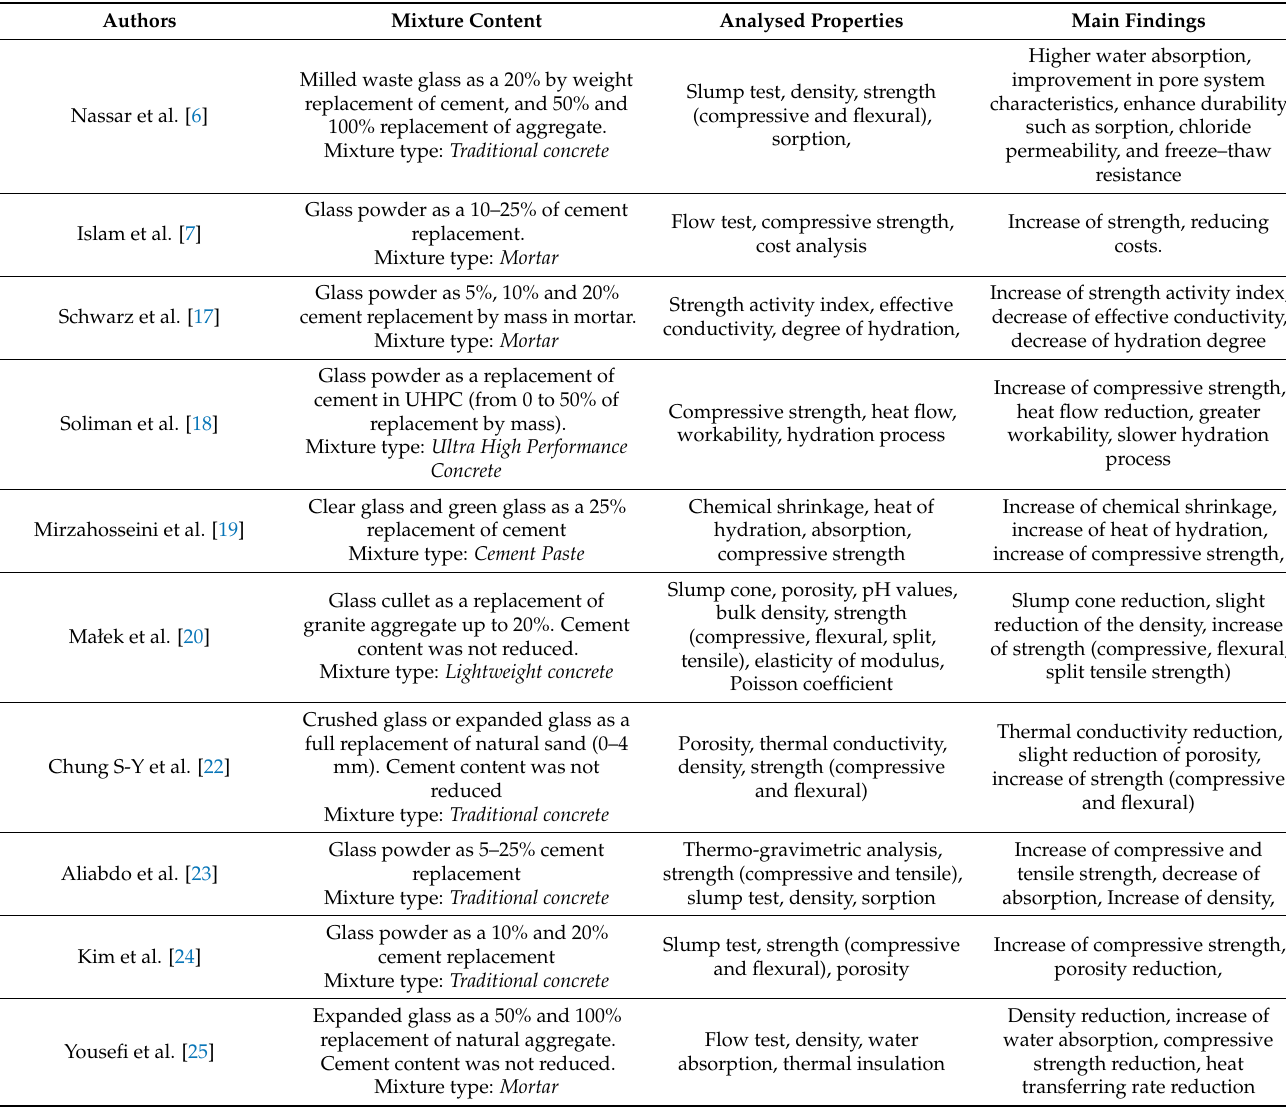
Table 1. Exemplary studies covering the topic of usage waste glass aggregate as an eco-friendly admixture.